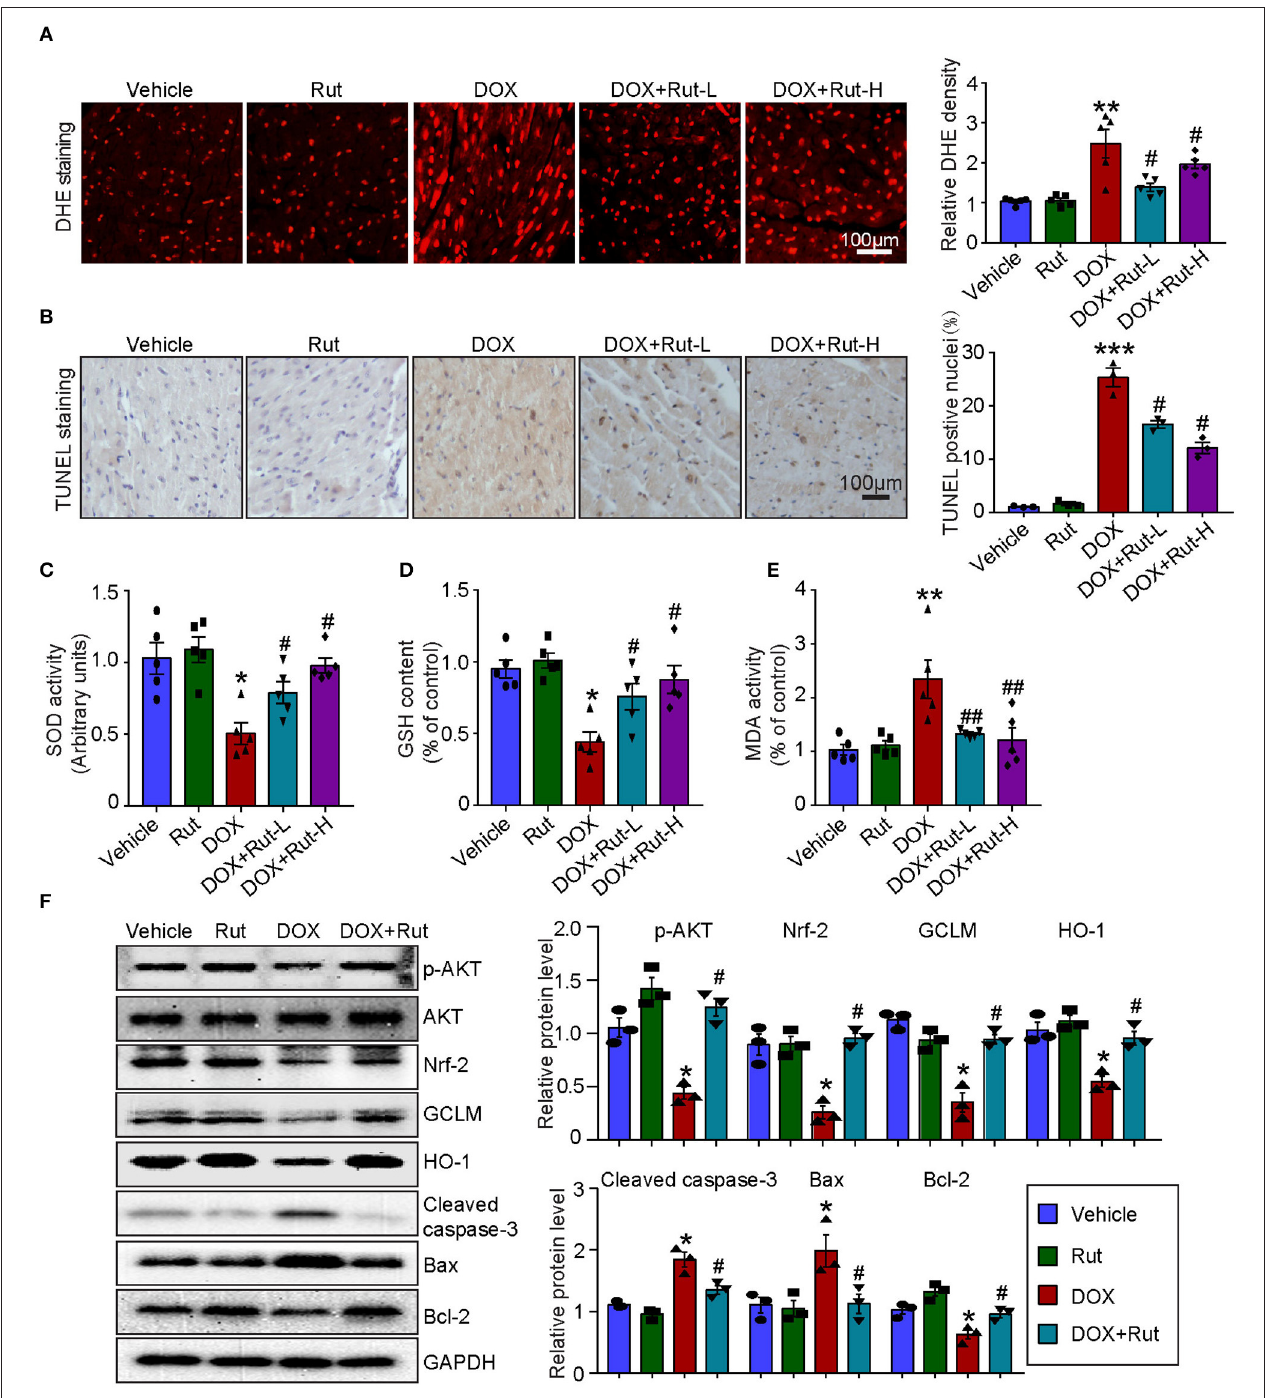
FIGURE 4 | Rutaecarpine alleviated DOX-induced oxidative stress and apoptosis. Mice were treated with DOX and then on the same day received 20 or 40 mg/kg Rut (intragastric administration) every day for 4 weeks. (A) ROS generation in the heart was detected by DHE staining, and the quantification of fluorescence intensity was shown right ( n = 5). Scale bar 100 µ m. (B) Representative TUNEL staining in the heart tissues and the TUNEL-positive nuclei were quantified ( n = 3, right). Scale bar 100 µ m. (C–E) Relative superoxide dismutase (SOD) activity, glutathione (GSH) content, and enhancement of malondialdehyde (MDA) activity in the heart; data in other groups were normalized to the vehicle group ( n = 5). (F) Western blot analysis of p-AKT, Nrf-2, GCLM, HO-1, cleaved caspase-3, Bax, and Bcl-2 in the heart and the relevant quantification was shown right (right, n = 3). * p < 0.05, ** p < 0.01, *** p < 0.001 vs. vehicle; # p < 0.05, ## p < 0.01 vs. DOX group.